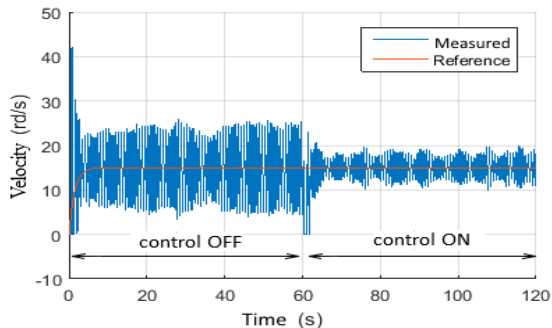
Figure 34. Noised drill bit velocity without and with H ∞ control activation.